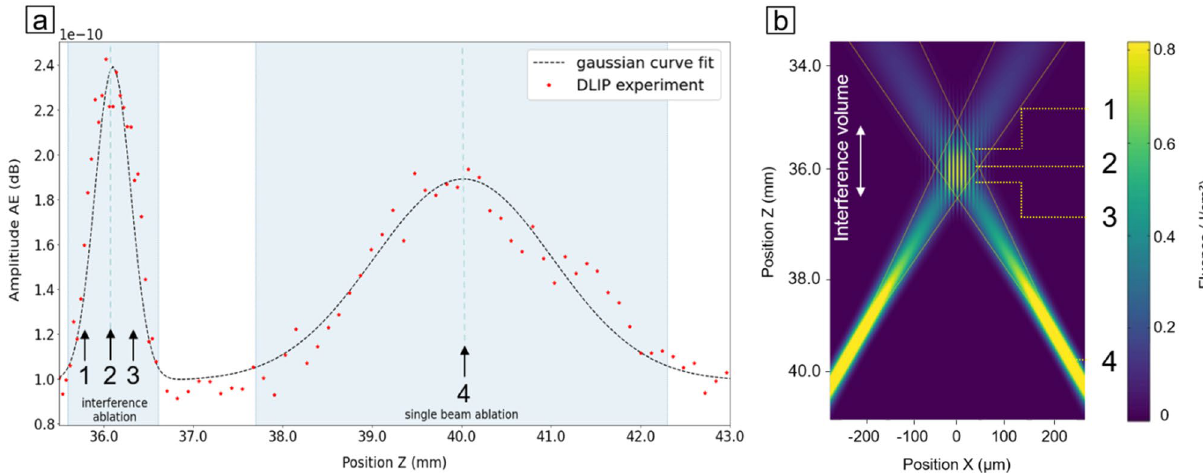
Figure 2. ( a ) Change of the AE signal with respect of the surface z position in relation to the laser head, ( b ) Simulation of the intensity of the interference volume generated by two focused laser